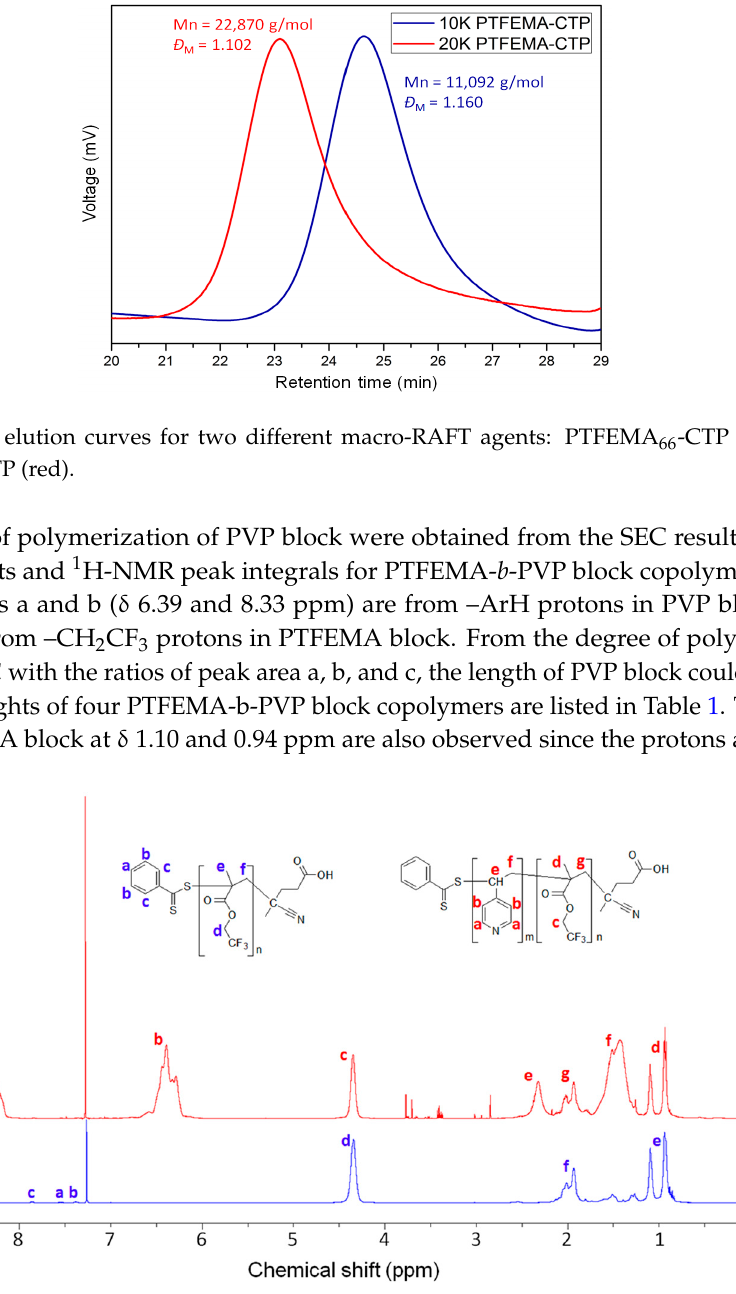
Figure 3. Representative 1 H-NMR spectra for ( a ) PTFEMA 66 -CTP and ( b ) PTFEMA 66 - b -PVP 41 block copolymer.